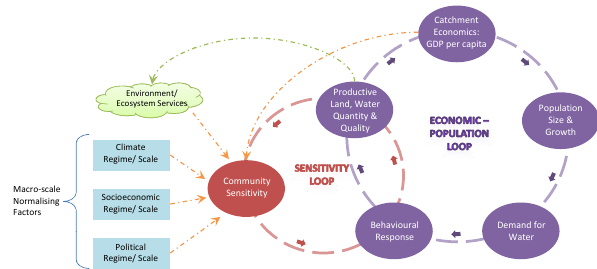
Figure 1. The socio-hydrology model as two interconnecting feed- back